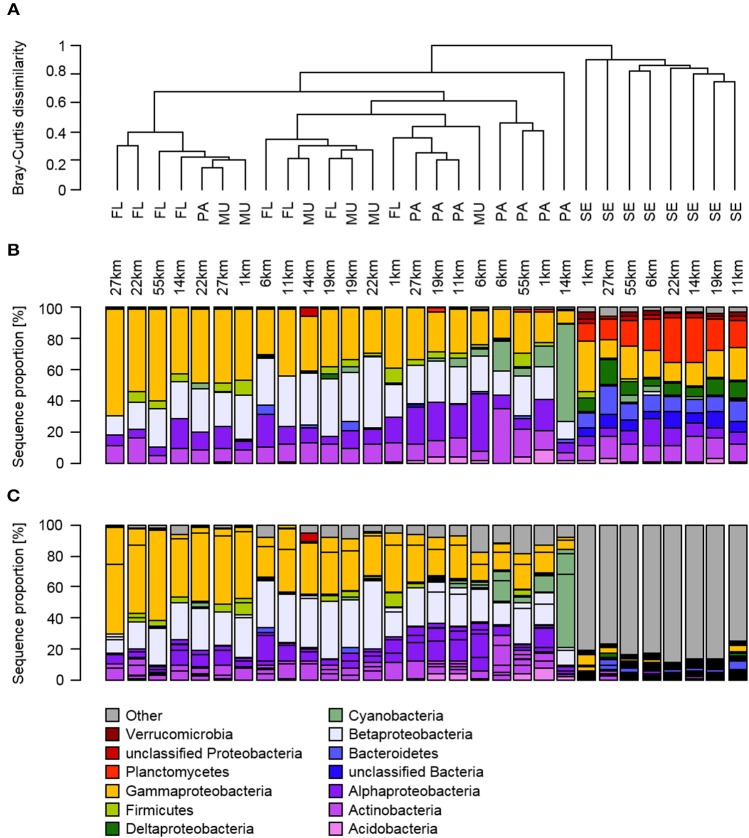
Relative abundance of bacterial phyla (B: top bar chart) and OTUs (C: bottom bar chart) in the free-living, particle-attached fraction of the water column and from Fungia mucus and sediments from inshore to outer shelf reef sites, as well as the hierarchical clustering based on Bray-Curtis dissimilarities (A: top part), of the investigated habitats according to their location on the shelf. The Proteobacteria in (B) are further identified to class level to accommodate for the high diversity and occurrence of biogeochemically important classes within that phylum.